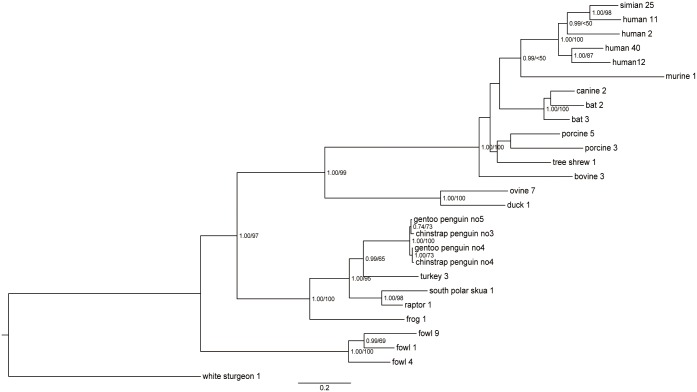
Phylogenetic analysis of amino acid sequences of penguin adenoviral hexon.The phylogenetic tree, based on entire hexon genome sequences of penguin adenoviruses, was generated using the Bayesian and maximum likelihood (ML) method. The first number indicates the Bayesian posterior probability, and the second number indicates the ML bootstrap value as a percentage. Scale bars indicate the number of nucleotide substitutions per site.